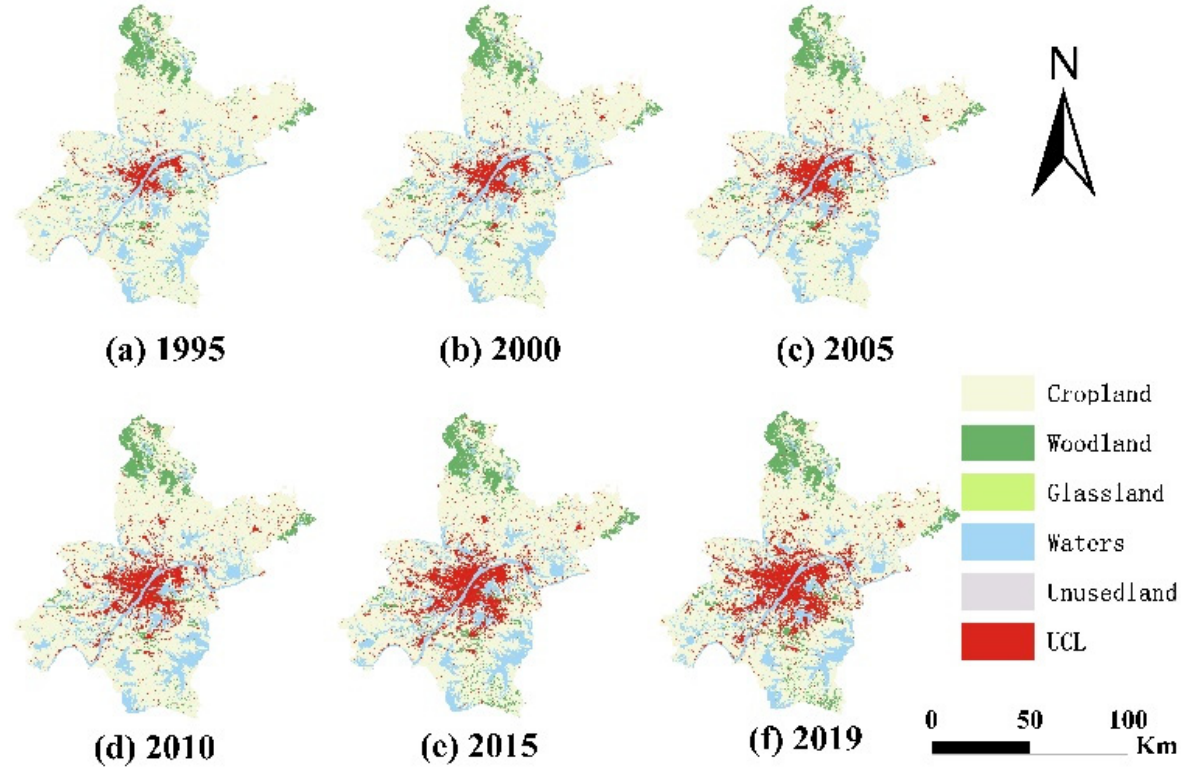
Figure 2. Land use in Wuhan, 1995–2019. (Take six points in time from 1995–2019: 1995, 2000, 2005, 2010, 2015, 2019).